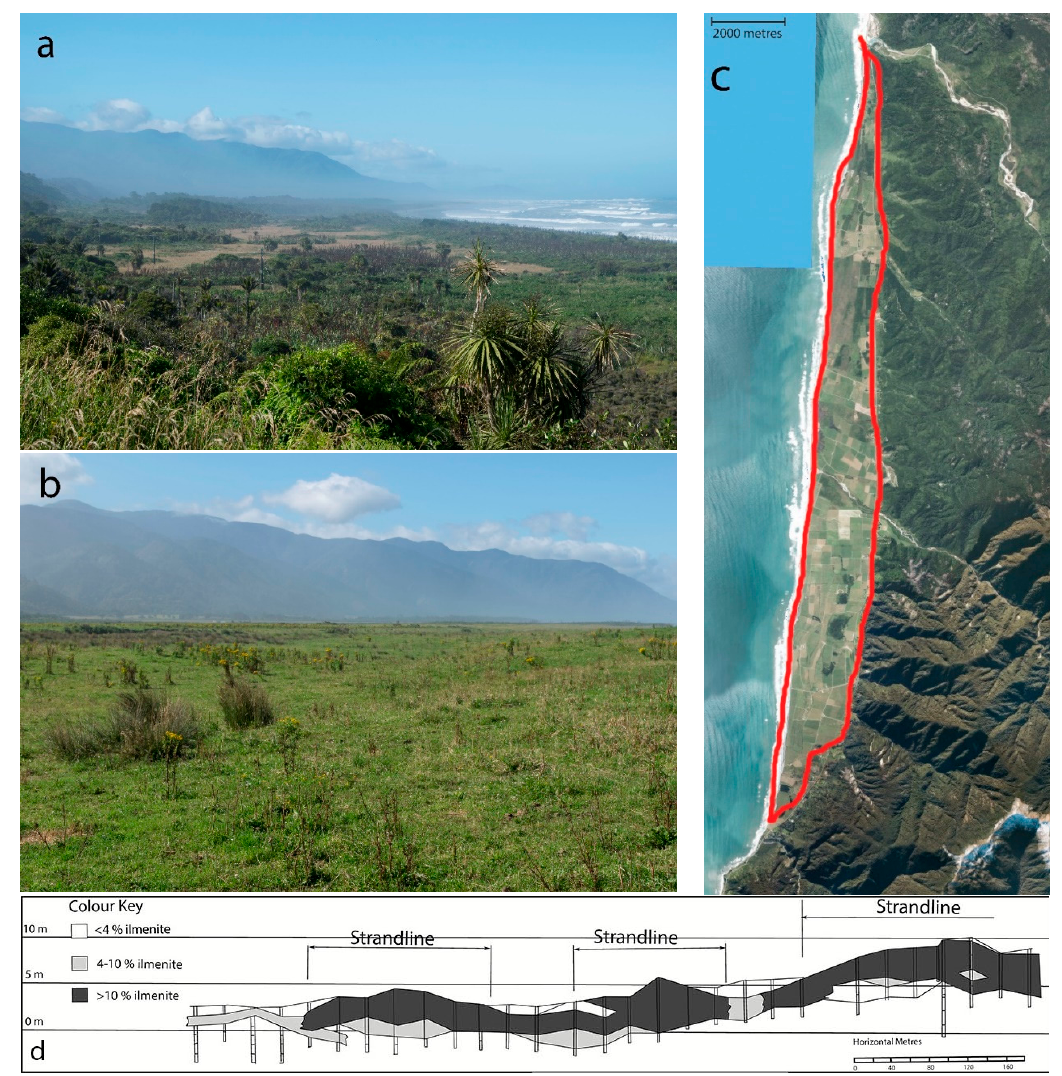
Figure 2. ( a ) Barrytown flats North, looking south (January 2019); ( b ) Barrytown flats South, looking south (January 2019); ( c ) aerial photo of Barrytown deposit (LINZ 2015–2106 summer); ( d ) sketch of cross section of deposit adapted from MR4295-3 Westland Ilmenite [18] .